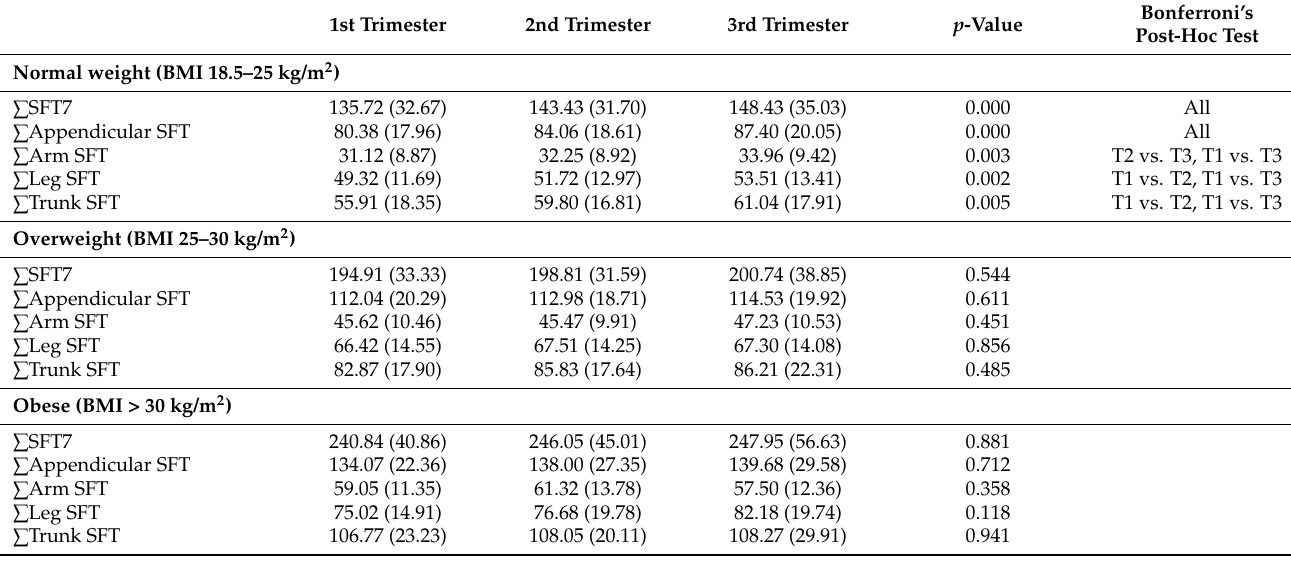
Table 3. Differences in skinfold for the three trimesters during pregnancy, stratified by BMI.